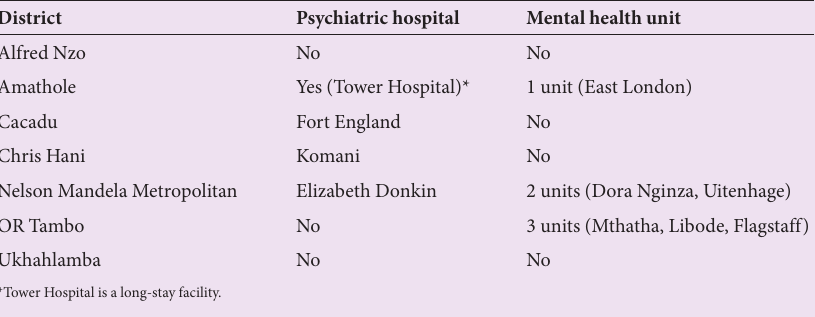
Table 1. Distribution of hospitals and mental health units in the Eastern